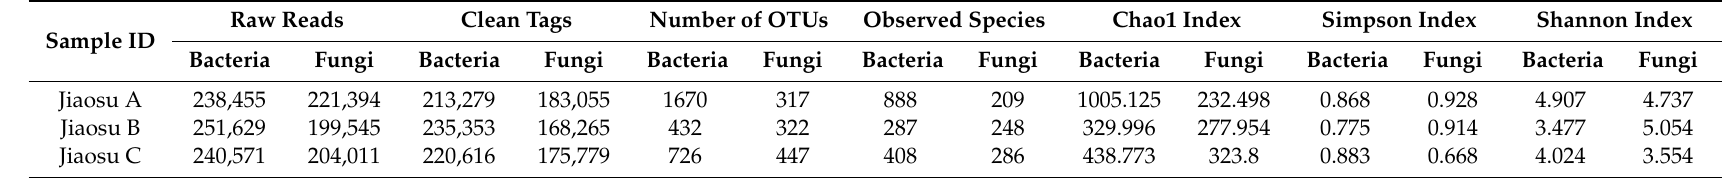
Table 1. Sequence abundance and microbial diversity of all